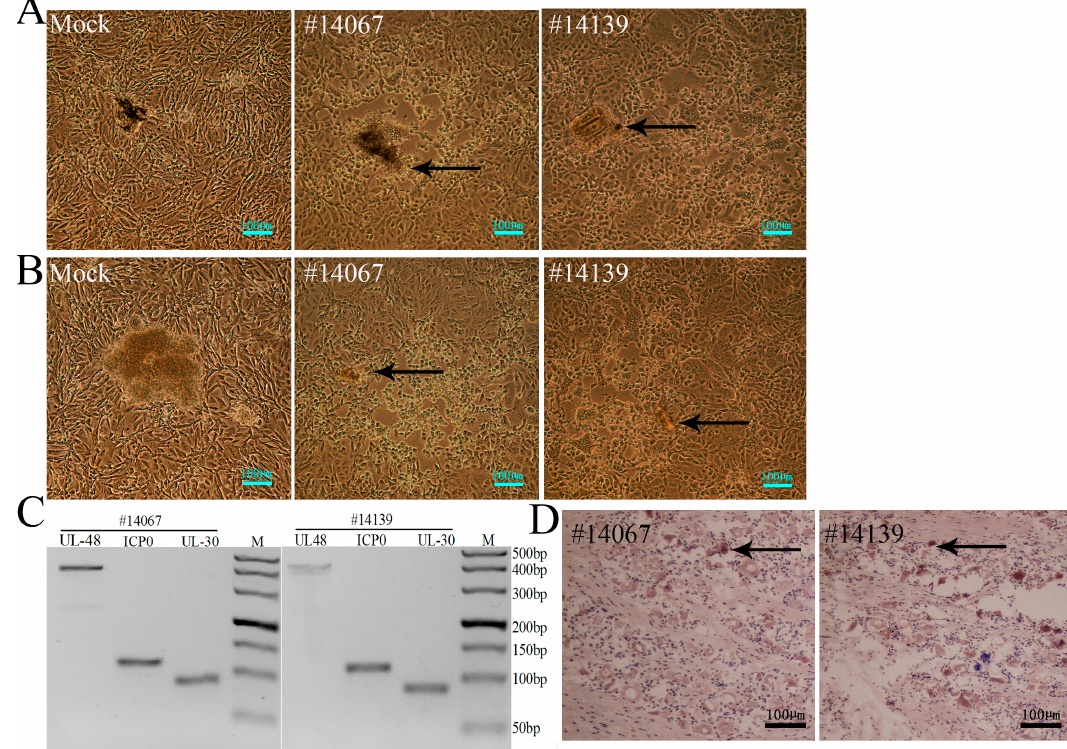
Figure 6. HSV1 was present in nervous tissues in a latent state one year post-infection. ( A ) co-cultured Vero cells with TG of No. 14067 and No. 14139. CPE is indicated by black arrows, scale bars = 100 µ m; ( B ) co-cultured Vero cells with pons of No. 14067 and No. 14139. CPE is indicated by black arrows, scale bars = 100 µ m; ( C ) viral genome detection of a mixture of TG tissues and co-cultured Vero cells by PCR amplification of DNA with primers against the UL48 (405 bp), ICP0 (114 bp) and UL30 (92 bp) genes; and ( D ) in situ hybridization of TG tissues of No. 14067 and No. 14139 using a specific LAT mRNA probe. Positive in situ hybridization results are indicated by black arrows, scale bars = 100 µ m.